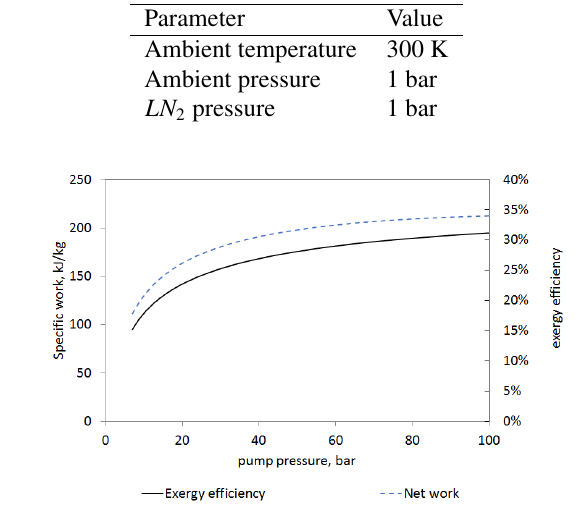
Figure 3. Exergy e ffi ciency and specific work of 2-stage direct expansion system as a function of pump